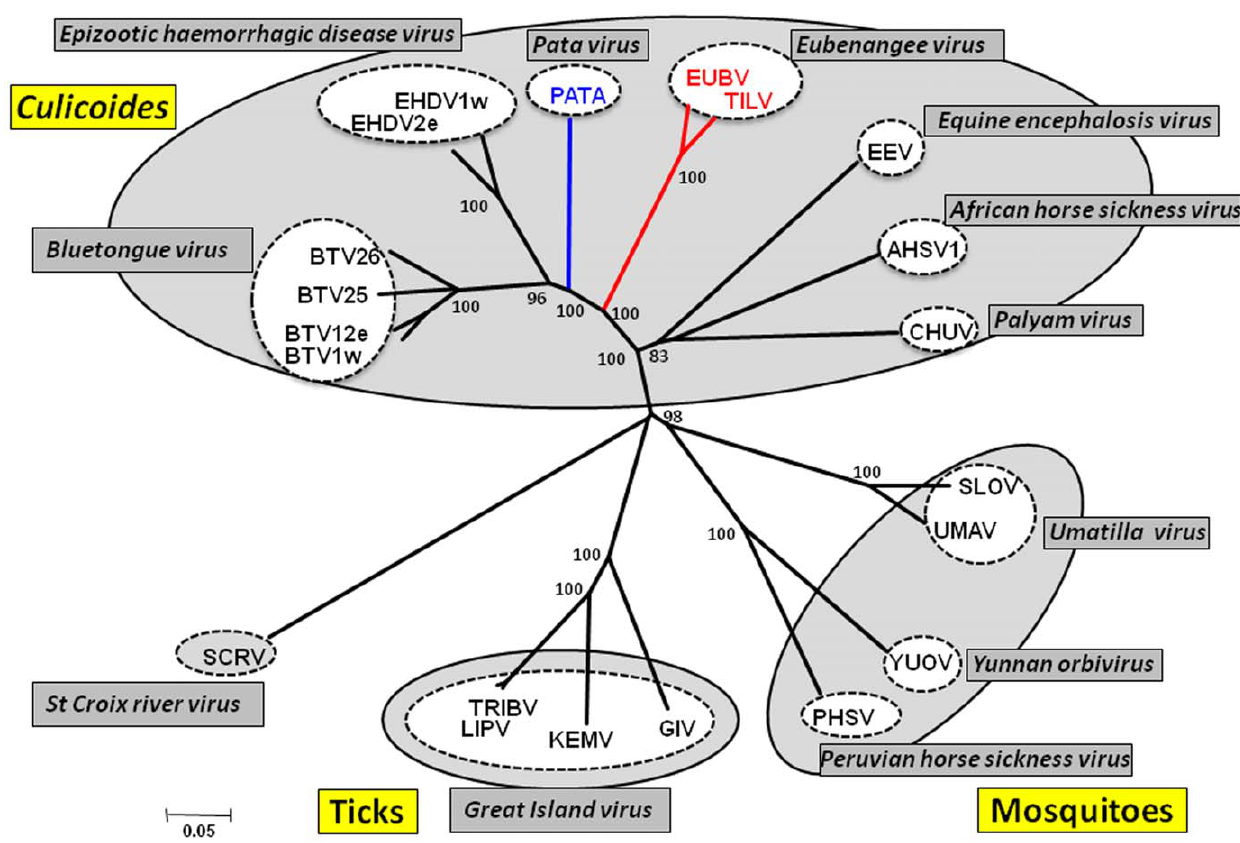
Figure 3. Neighbour-joining tree showing the relationships between amino acid sequences of VP1 polymerase (RdRp) protein of different orbiviruses. The EUBV and TILV isolates characterised in this study are shown in red font, and PATAV is shown in blue font. Full names of virus isolates and accession numbers of polymerase sequences used for comparative analysis are listed in Table S2 (supplementary data). ‘e’ and ‘w’ after serotype number indicate eastern and western strains, respectively.